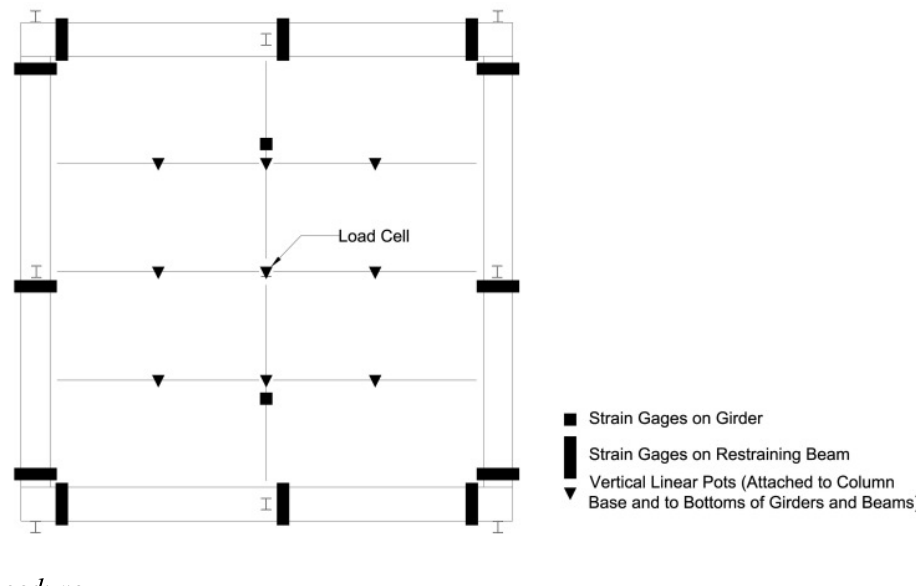
Figure 9. Test specimen instrumentation